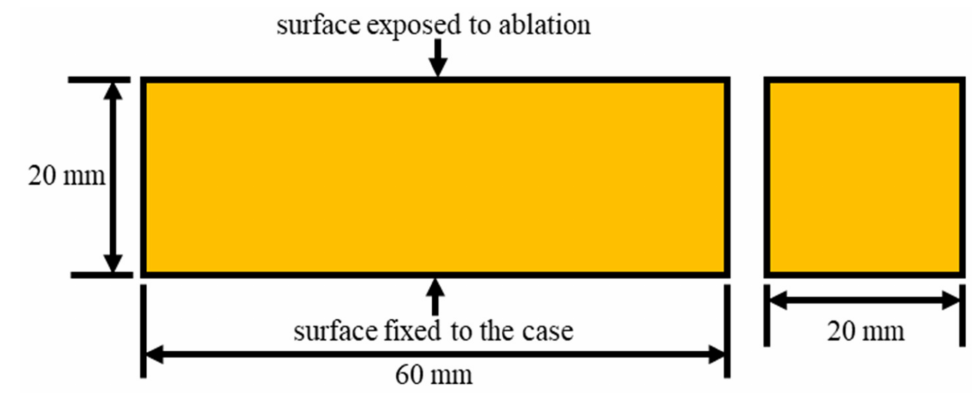
Figure 9. Schematic diagram of specimen size.